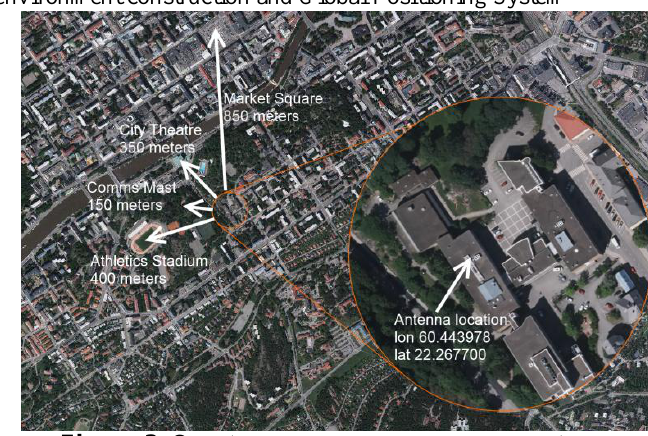
Figure 3. Spectrum occupancy measurement antenna in Turku,